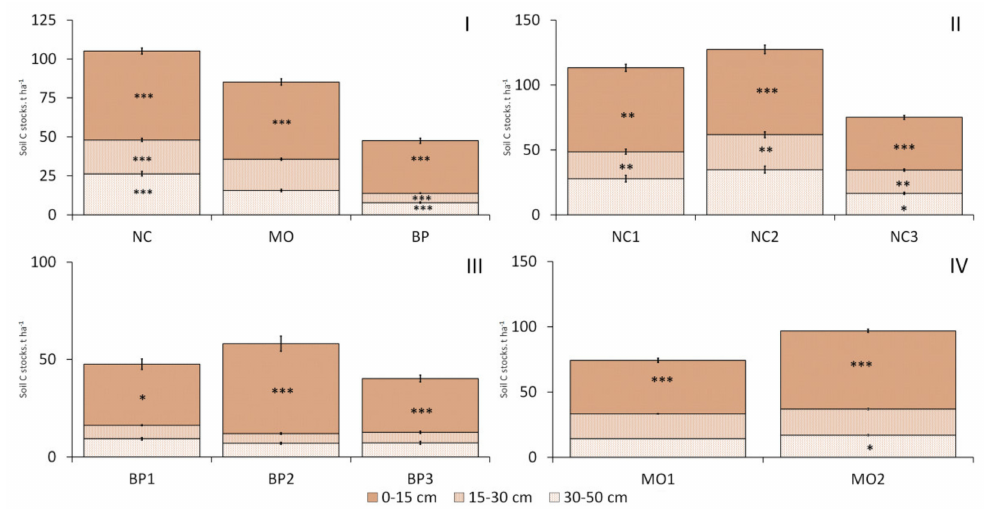
Figure 4. Soil carbon stocks in in the 50-cm mineral layers in ( I ) forests of three areas NC—Northwest Caucasus (n = 99), MO—Moskva-Oka plain (n = 69), BP—Bryansk Polesie (n = 83). ( II ) Forest types in NC: NC1—hornbeam–aspen (n = 30), NC2—hornbeam–fir–beech (n = 36), NC3—beech–fir (n = 33). ( III ) Forest types in BP: BP1—pine (n = 22), BP2—pine–broadleaf (n = 22), BP3—broadleaf–spruce (n = 39). ( IV ) Forest types in MO: MO2—spruce–broadleaf (n = 30), MO1—lime–birch (n = 39). Asterisks indicate the significance of the differences between the mean in category and overall mean: *— p ≤ 0.1, **— p ≤ 0.01, ***— p ≤